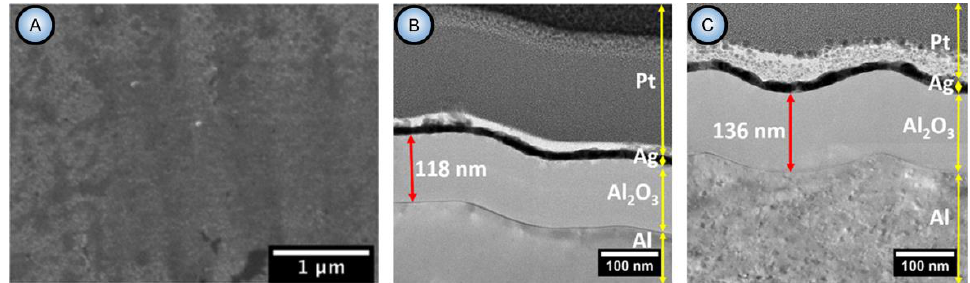
Figure 5. An SEM image ( A ) and a cross-sectional TEM (FIB-TEM) image ( B ) of a barrier-type anodic alumina layer prepared by anodizing in 0.3 M periodic acid (H 5 JO 6 ) solution (pH = 1.1) at a constant applied voltage of 80 V. For comparison, an FIB-TEM image of a barrier-type film prepared in a citrate buffer solution (pH = 5.8) at 100 V is shown in ( C ). Reproduced with permission from [88]. Copyright 2020 American Chemical Society.